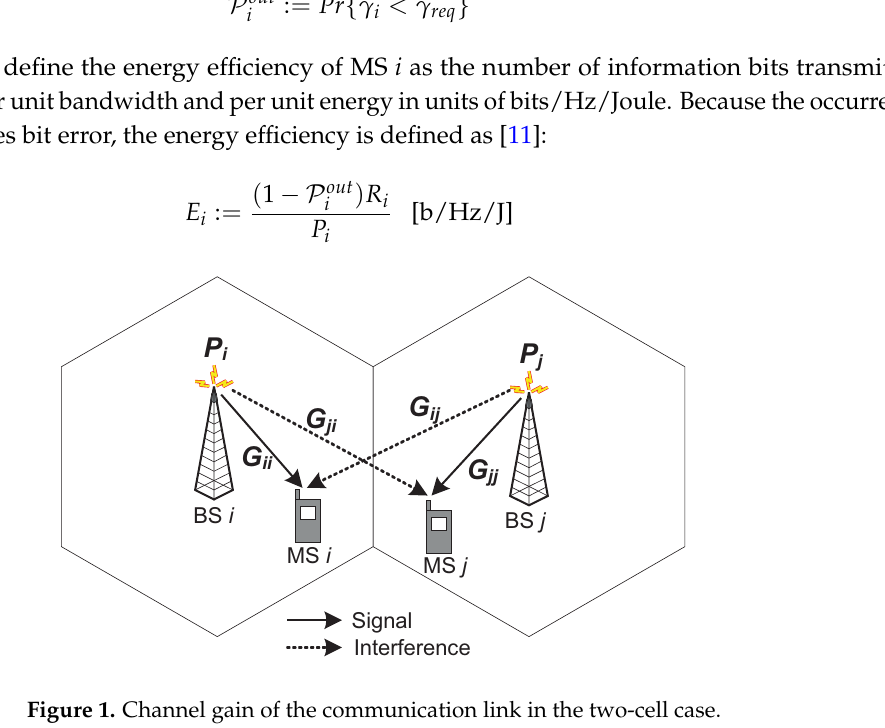
Figure 1. Channel gain of the communication link in the two-cell